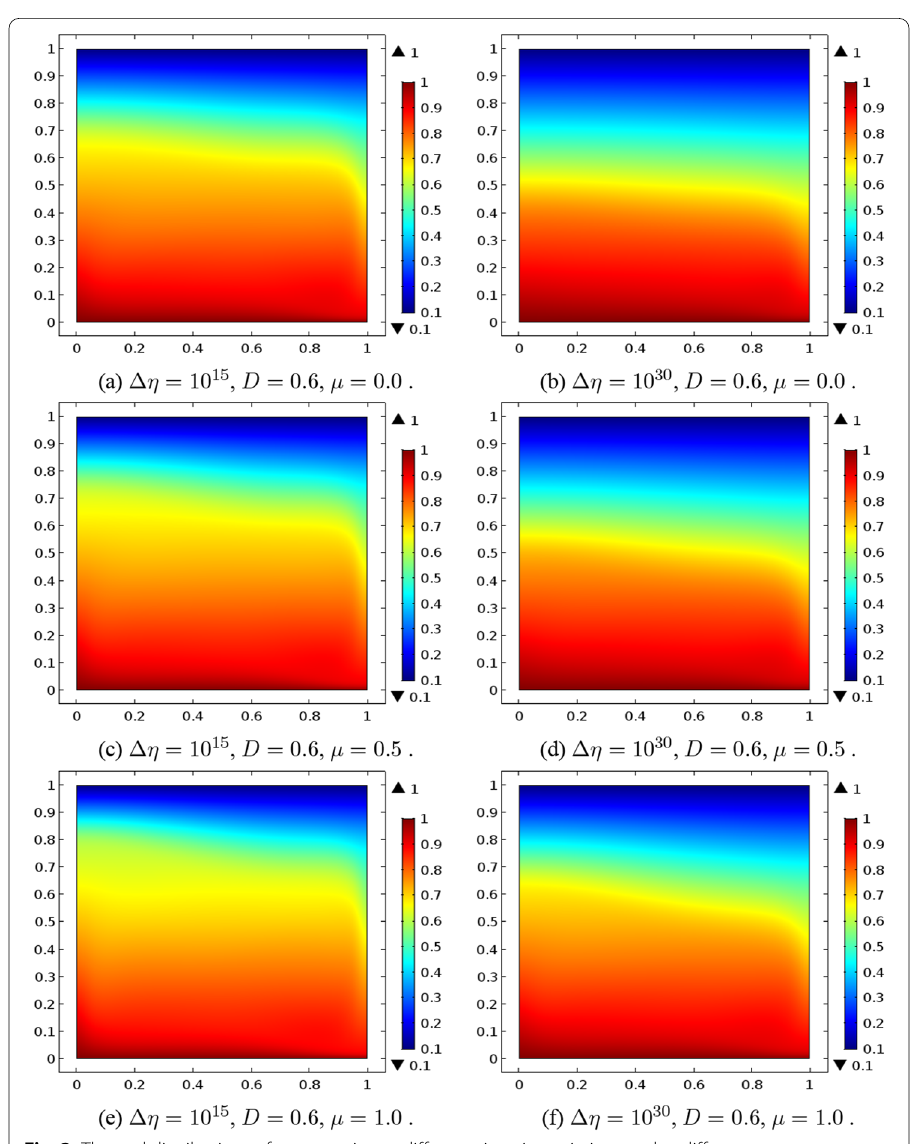
Fig. 3 Thermal distributions of a convection at different viscosity variations and at different pressure numbers for a fixed viscous dissipation number D = 0.6 with θ 0 = 0.1 and Ra = 10